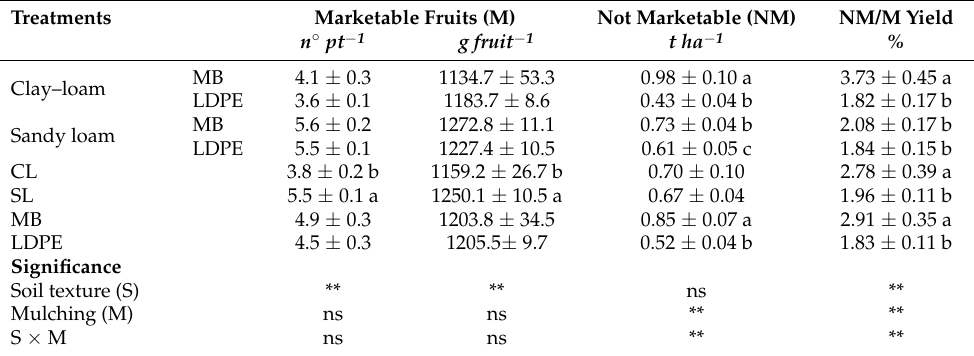
Table 1. Effect of soil texture (clay–loam—CL; sandy loam—SL) and mulching (biodegradable film—MB; low density polyethylene—LDPE) on the number of marketable fruits and their average weight, unmarketable yield, and percentage incidence of unmarketable to marketable yield.